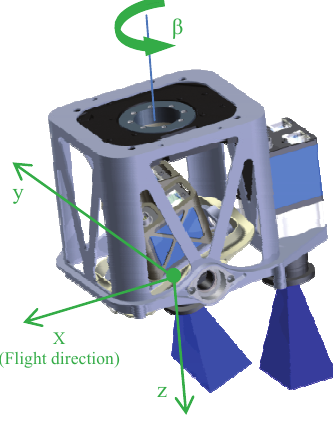
Figure 9. Sensor head with tumbling camera (left) and a nadir- pointed camera, coordinate system of sensor head That way by only one rotational movement not only four major perspectives can be reached, in fact arbitrary perspectives are obtainable (circular around the nadir point). The dependency between gear velocity and camera acquisition rate determines the overlap of two consecutive